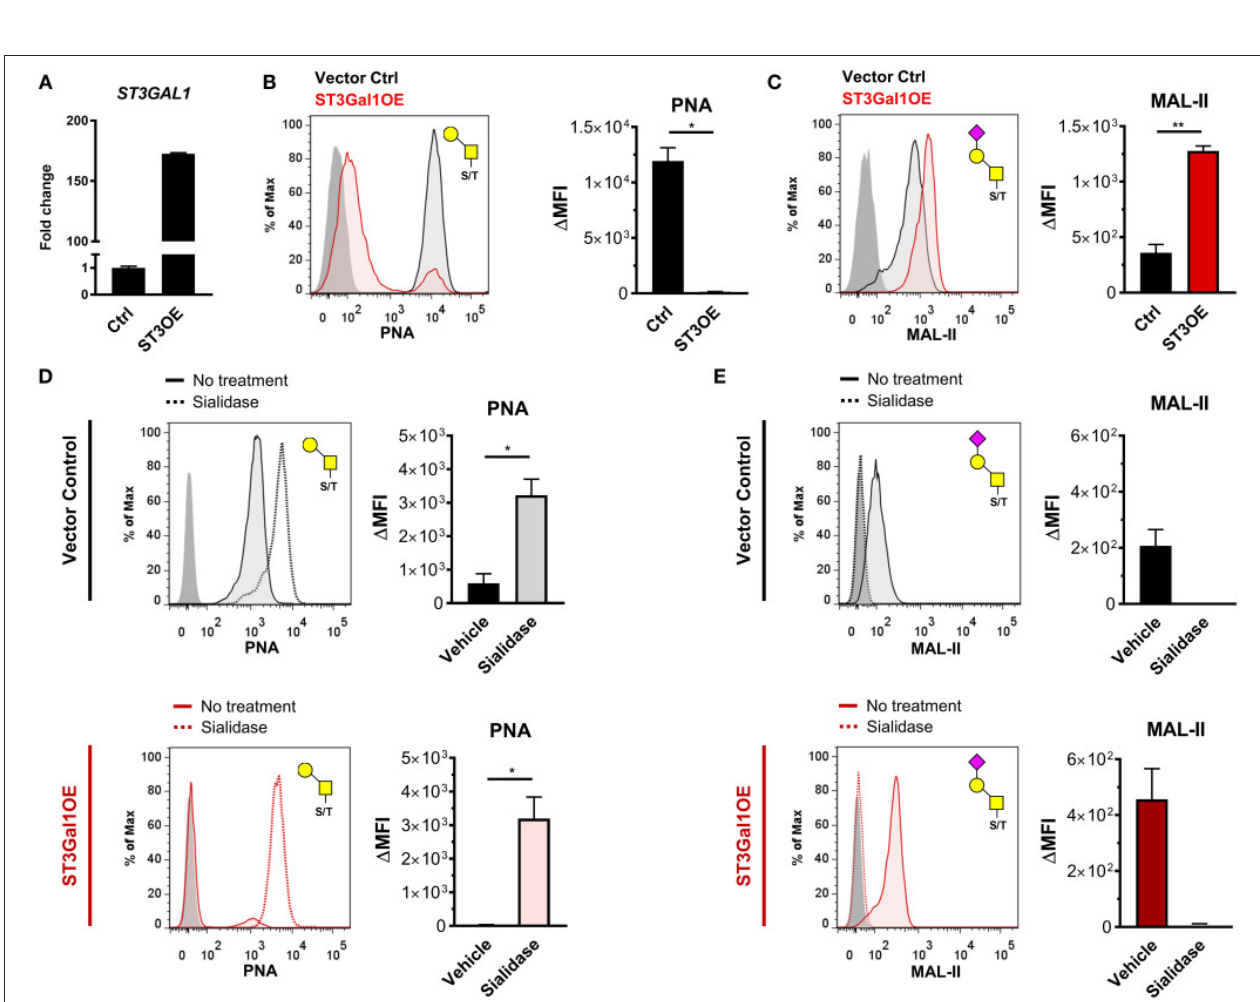
FIGURE 1 | controls used for gating of CD27 are shown. (B) Analysis of peanut lectin binding to human tonsil B cells. Representative histograms of results are shown ( left ) as well as quantification of geometric mean fluorescence intensities (MFI) ( right ). (C) Schematic of synthesis of potential PNA-reactive O-linked glycans on B cells. O-glycan synthesis is initiated in the Golgi apparatus by polypeptide N-acetylgalactosamine transferases ( GALNTs ), which transfer a single GalNAc to select serine/threonine residues of a polypeptide backbone. The initiating GalNAc can be terminally sialylated, or further extended by C1GalT1 ( C1GALT1 ) to form the simplest PNA-reactive epitope, a Core 1 O-glycan termed “T-antigen.” This core T-antigen moiety can be branched and elongated by other glycosyltransferases to form extended Core 2 O-glycans, which retain binding to PNA, or modified with sialic acid by the α 2,3-sialyltransferase ST3Gal1 ( ST3GAL1 ), which destroys PNA reactivity. Endogenous (or exogenous) sialidases may remove sialic acids and restore PNA binding. (D) Analysis of ST3GAL1 expression in tonsillar B cells by quantitative real-time reverse transcription PCR (qRT-PCR), sorted as in (A) . Data are normalized to the housekeeping gene VCP and presented relative to naïve B cells. Data are representative of eight (B) or three (D) distinct tonsil specimens pooled from two (B) or three (D) independent experiments. Statistics were calculated using a Kruskal–Wallis test with Dunn’s multiple comparisons test (B) or One-way analysis of variance (ANOVA) and Tukey’s multiple comparisons test. Throughout, bars and error bars depict the mean and SEM, respectively. ns = not significant, *** p ≤ 0.001. 1 MFI, background subtracted geometric mean fluorescence intensity; GalNAc, N-acetylgalactosamine; Gal, galactose; Sia, sialic acid.